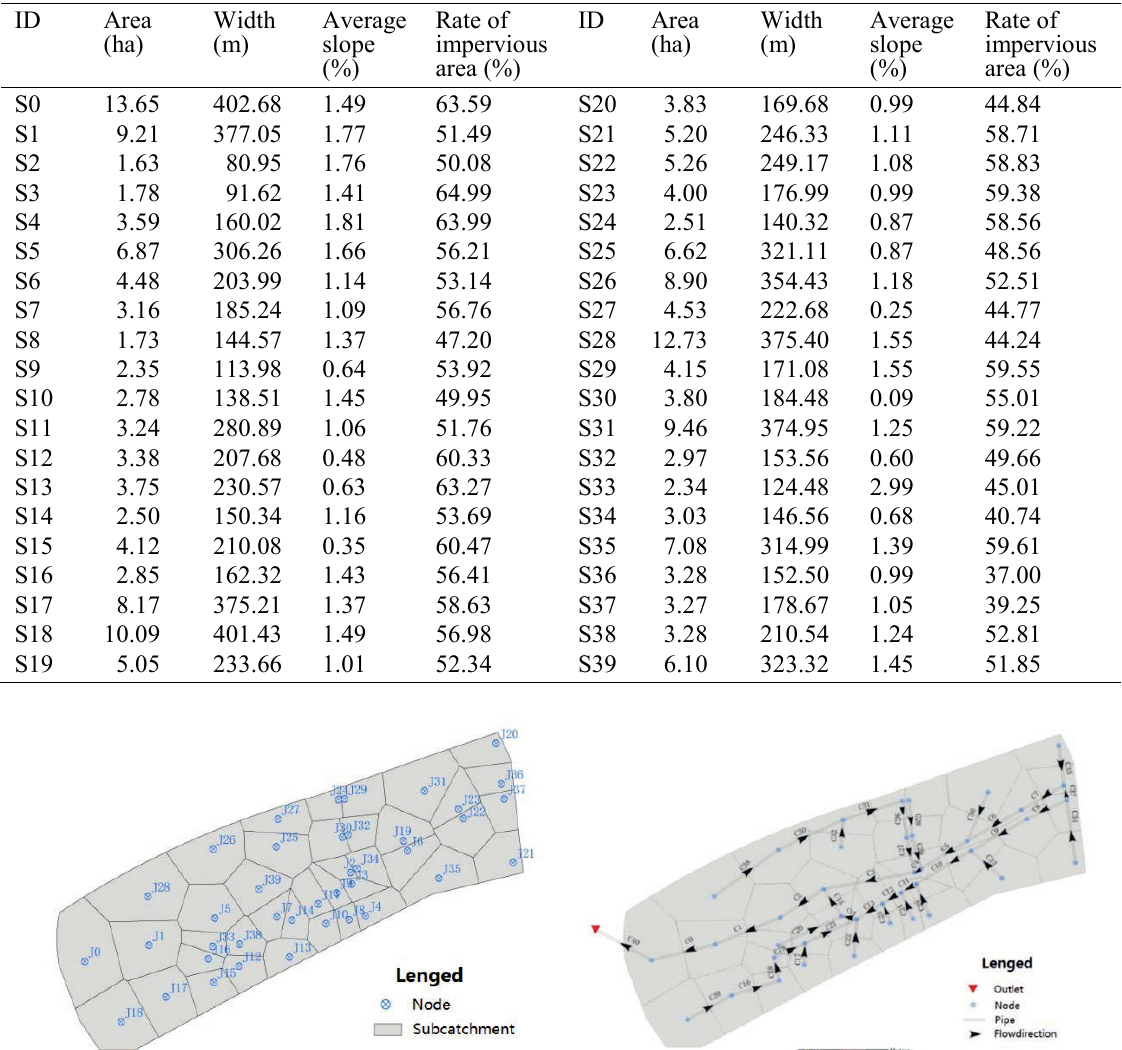
Table 1 Basic subcatchment